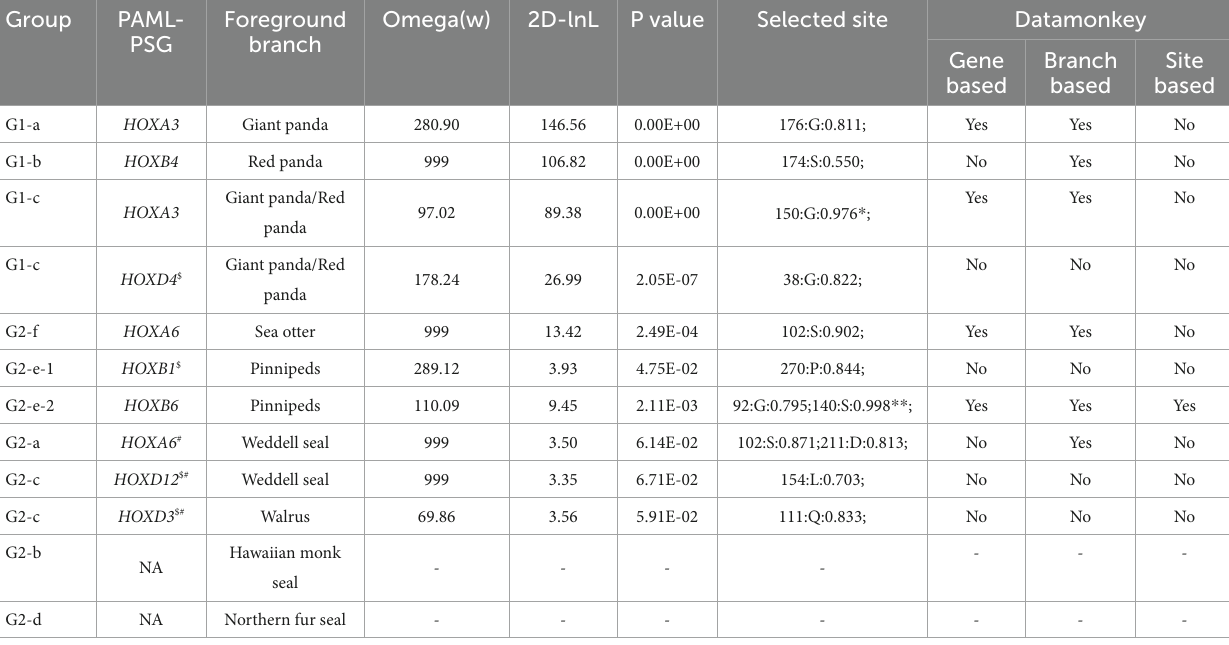
TABLE 1 Detection of positively selected genes (PSGs) using PAML and Datamonkey.